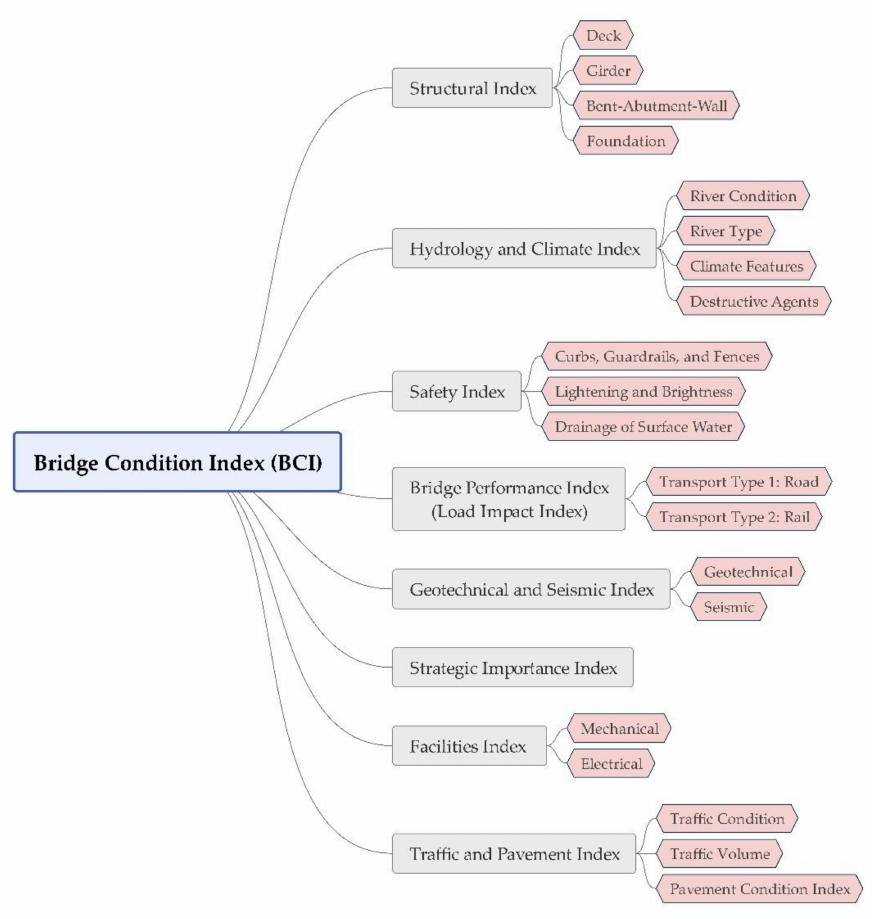
Figure 3. Hierarchy tree in this